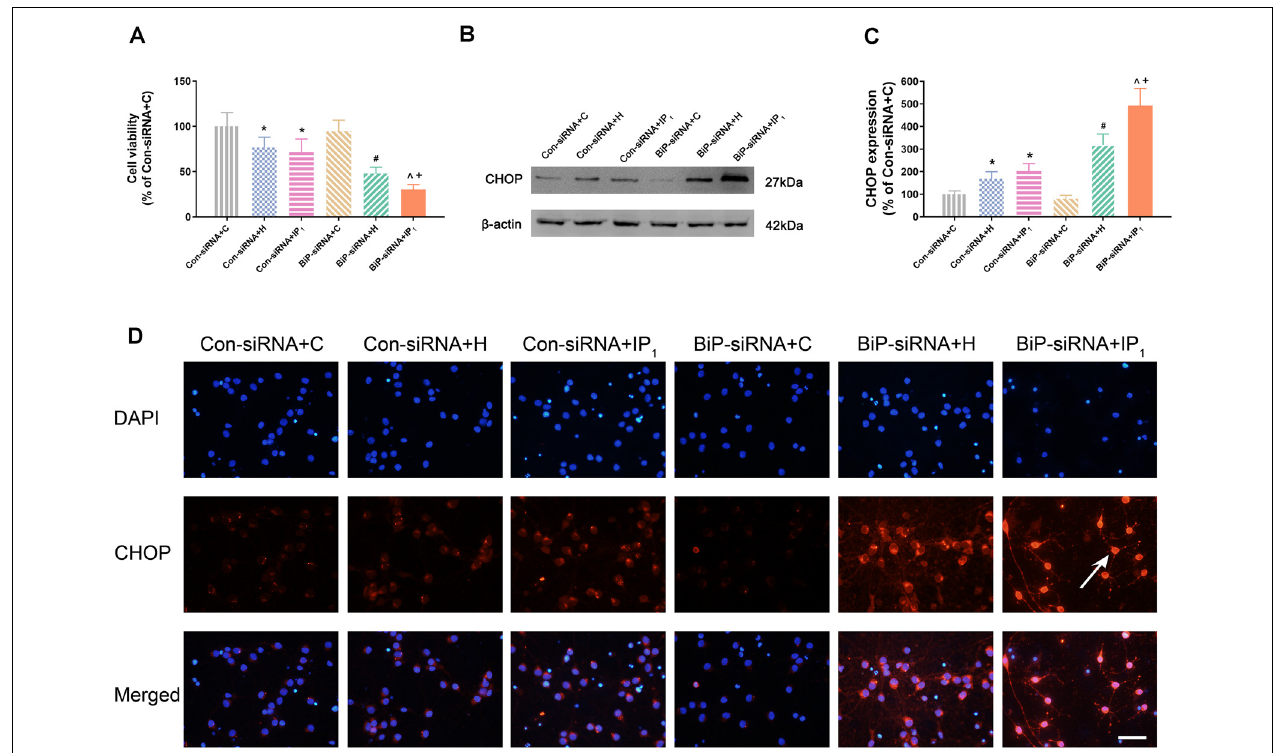
FIGURE 3 | Knockdown of BiP by siRNA aggravated the neuronal injury and endoplasmic reticulum (ER) stress caused by anesthetics. (A) Statistical graph of the neurons viability determined by the Cell Counting Kit-8 (CCK8) assay. Data are expressed as the mean ± SD ( n = 6/group). (B,C) The expression of CHOP in hippocampal neurons was determined by Western blotting. Data are expressed as the mean ± SD ( n = 6/group). One percent isoflurane and 1.2 µ g/ml of propofol significantly up-regulated CHOP protein expression in neurons after treatment with BiP siRNA. * P < 0.05 compared with group Con-siRNA + C; # P < 0.05 compared with group Con-siRNA + H; ∧ P < 0.05 compared with group Con-siRNA + IP 1 ; + P < 0.05 compared with group BiP-siRNA + H. (D) Immunofluorescent microscopy for CHOP. Nuclear was stained by DAPI; CHOP antibody was marked by rhodamine Red-X. Scale bars = 50 µ